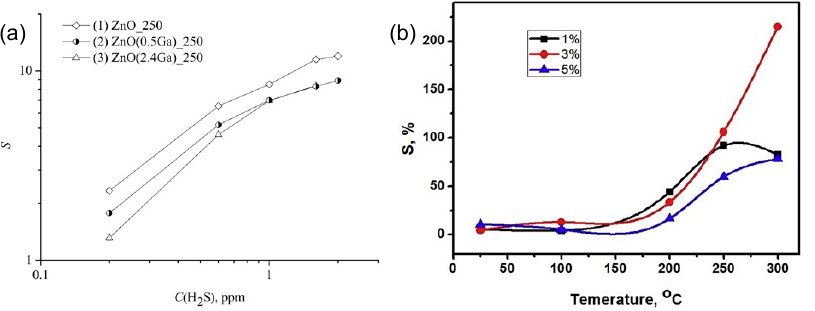
Figure 16. ( a ) H 2 S Response of Ga-doped ZnO gas sensors as a function of the gas concentration [227]. Copyright 2013 Elsevier. ( b ) H 2 S Response of Ga-doped ZnO gas sensors as a function of the temperature [229]. Copyright 2018